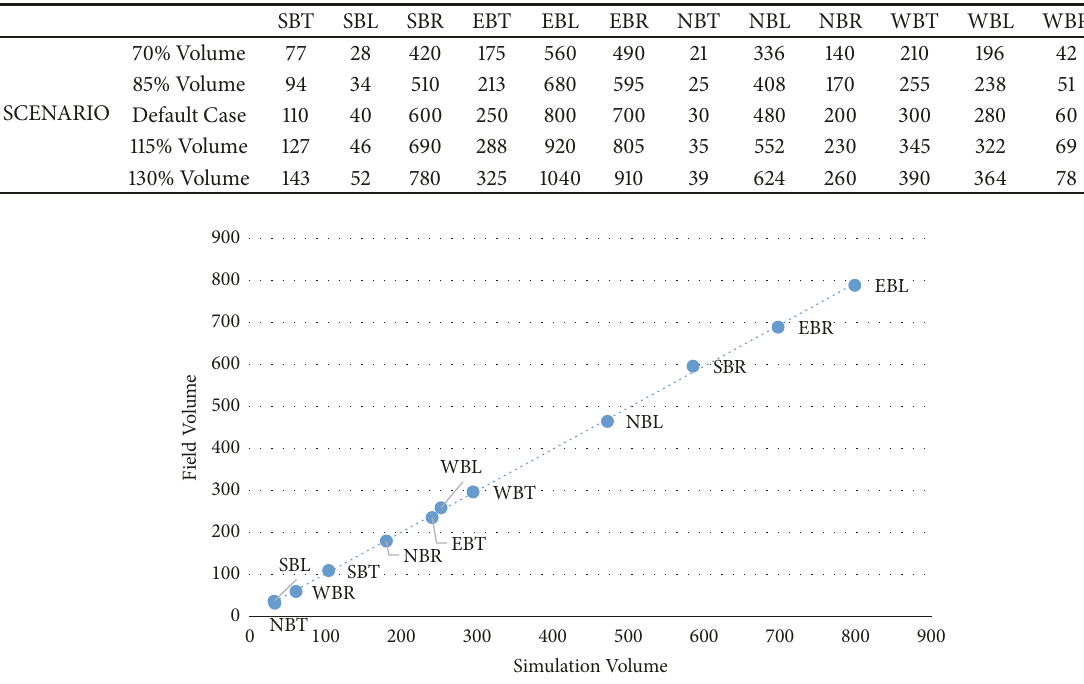
Figure 2: Volume contrast (field vs